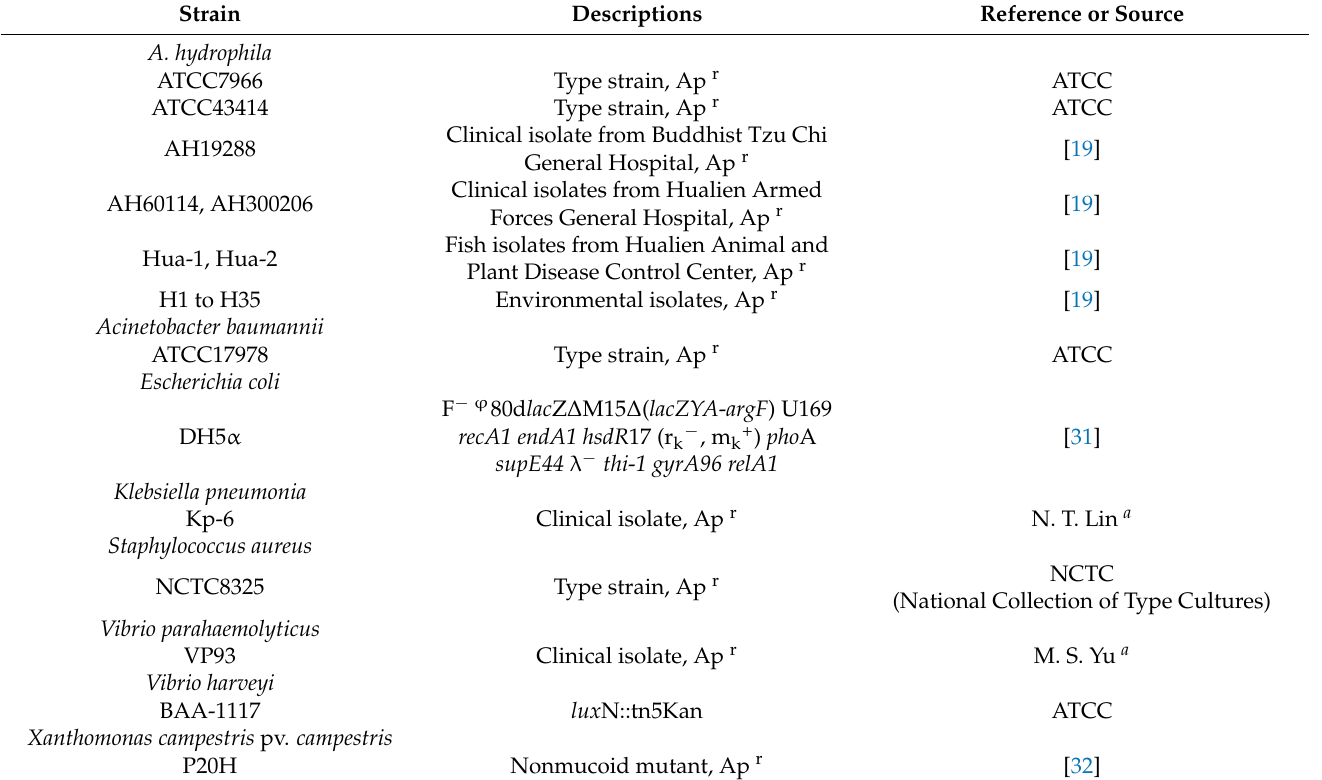
Table 1. Bacterial strains used in this